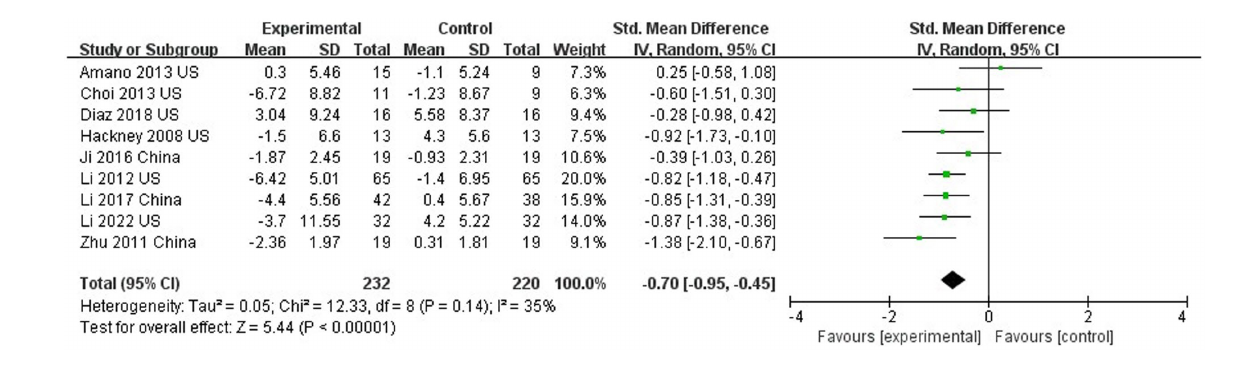
FIGURE 3 The effect of Tai Chi on motor function.